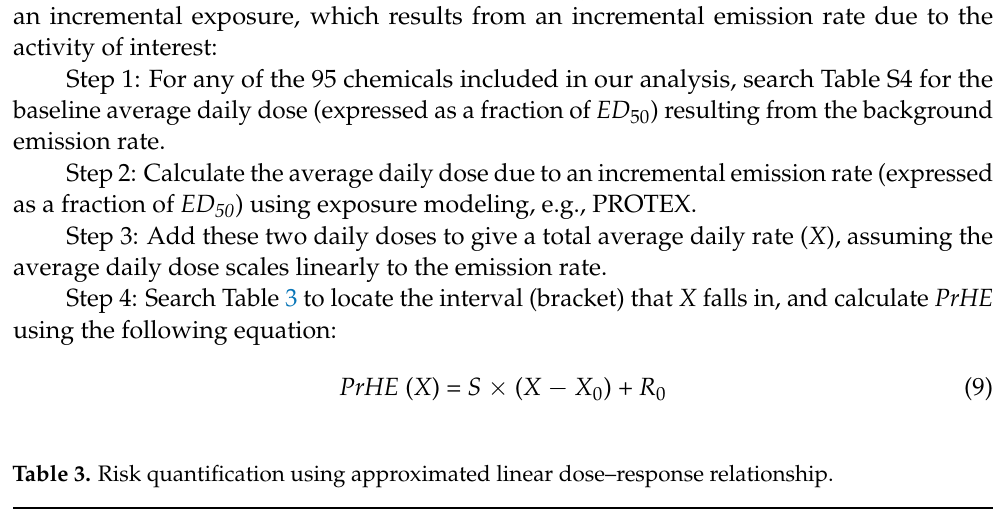
Table 3. Risk quantification using approximated linear dose–response relationship. Dose as a Interval Fraction of ED